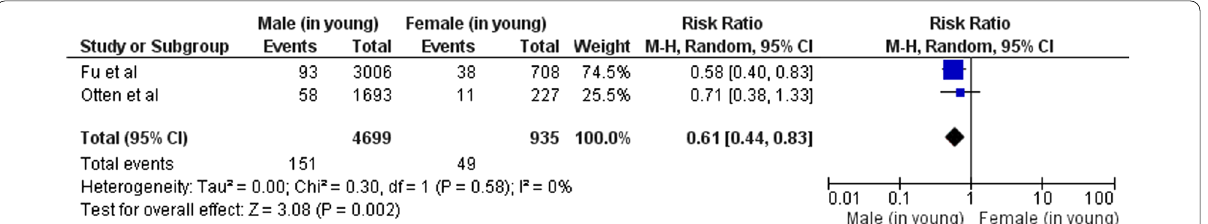
Fig. 9 Death after PCI in male versus female under 60 years old and with STEMI